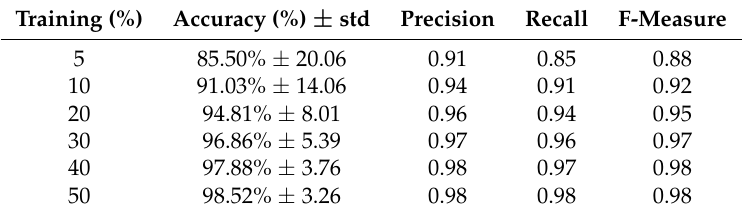
Table 3. Classifier performance by training set